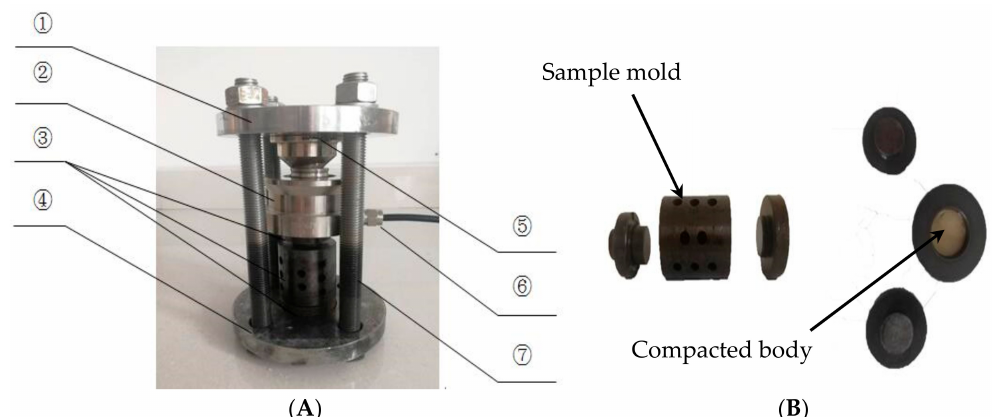
Figure 4. A schematic diagram of the expansion stress testing apparatus ( 1 (cid:79) : top plate; 2 (cid:79) : sensor; 3 (cid:79) : sample mould; 4 (cid:79) : bottom plate; 5 (cid:79) : anti-load measuring head; 6 (cid:79) : data acquisition system; 7 (cid:79) : constrained screw). ( A ) Expansion stress test apparatus; ( B ) Sample